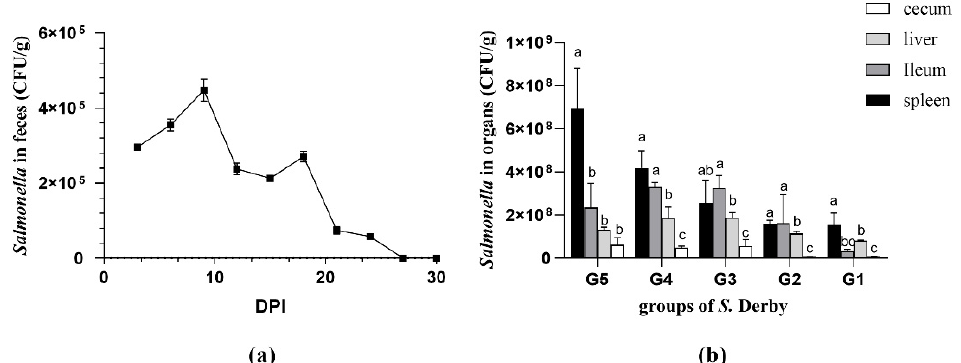
Figure 4. Fecal shedding and organ bacterial loads of the Salmonella ( S.) Derby strain in the mouse model. ( a ) Fecal pellets were collected from the KM mice at the indicated time points for 30 days (or until the animal was sacrificed). The shedding of S. Derby was at about 24 days. Dots represent mean ± SD (Standard deviation) CFU (colony-forming units) counts in pellets of each mouse group; ( b ) Colonization in systemic and intestinal sites. Bacterial load in each mouse is represented as CFU/g by the individual column in the spleen (black columns), liver (light gray columns), ileum (gray columns), and cecum (white columns) at different doses. Group1-Group5 (G1–G5): The mice in G1–G5 were intraperitoneally injected with the following doses of salmonella: 5 × 10 5 , 5 × 10 6 , 5 × 10 7 , 5 × 10 8 , and 5 × 10 9 CFU. Letters indicate significant differences between organs in each group after multiple comparisons.